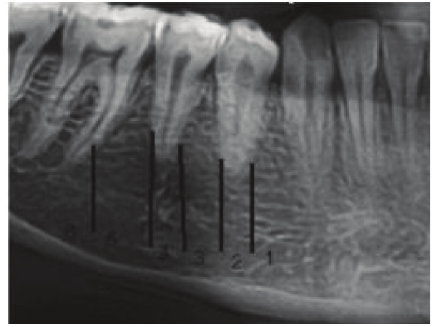
Figure 2: The horizontal position of mental foramen.